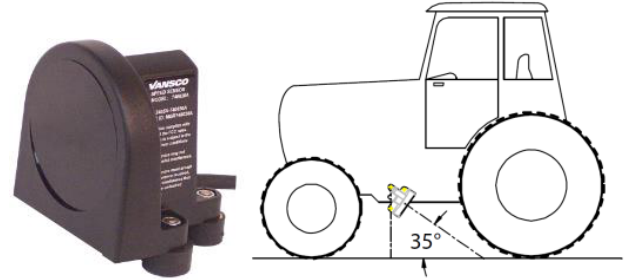
Figure 4. Speed radar and installation angle.